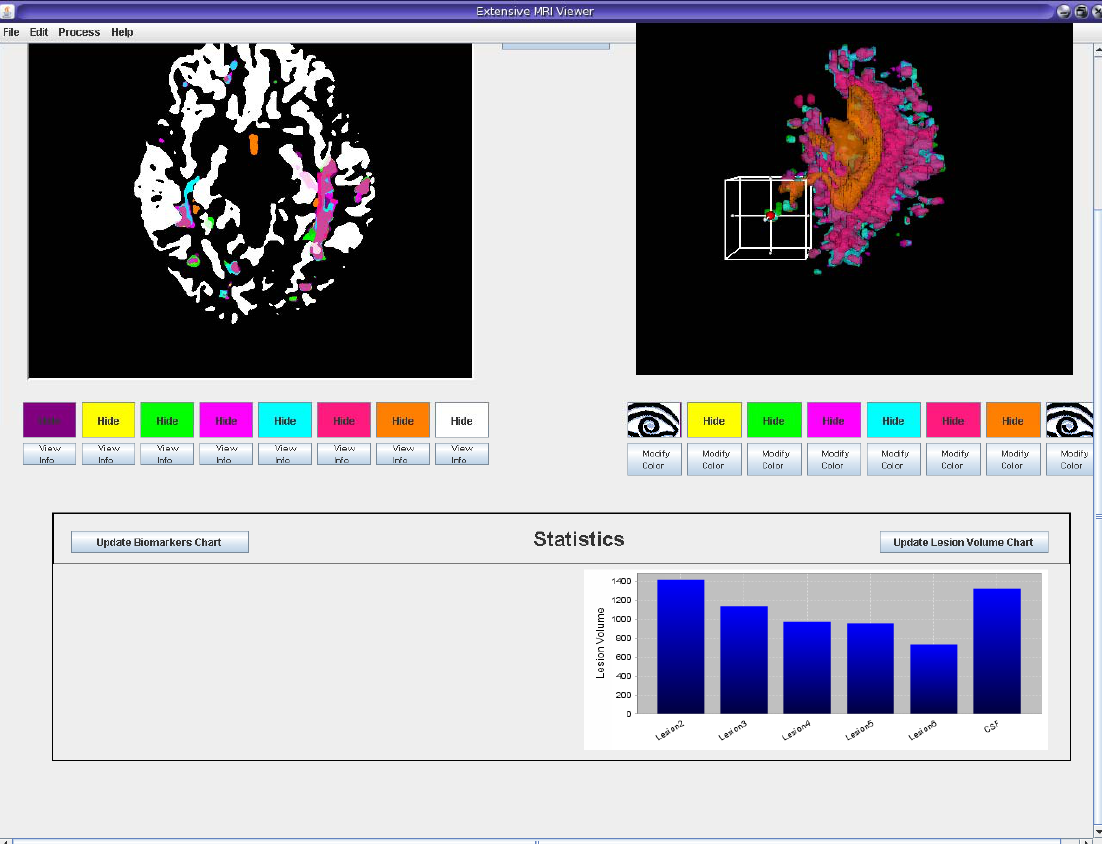
Figure 3: Visualizing lesions extracted from multiple scan sessions. 2D stacks of lesion masks and 3D lesion models are loaded and shown together, distinguished by unique